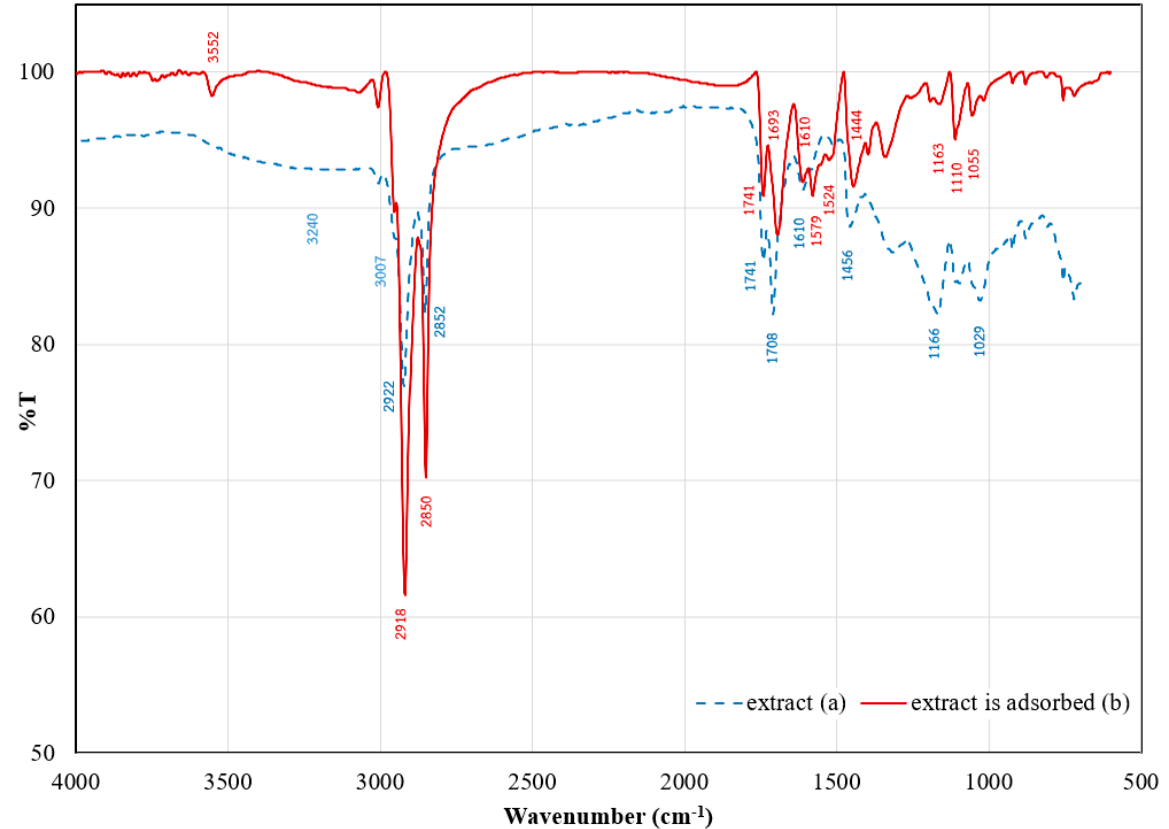
Figure 5. FT–IR spectra of ( a ) Terminalia bellirica fruit extract ( b ) 304 stainless steel surface after immersed in hydrochloric acid solution with 300 mg L − 1 of Terminalia bellirica fruit extract.